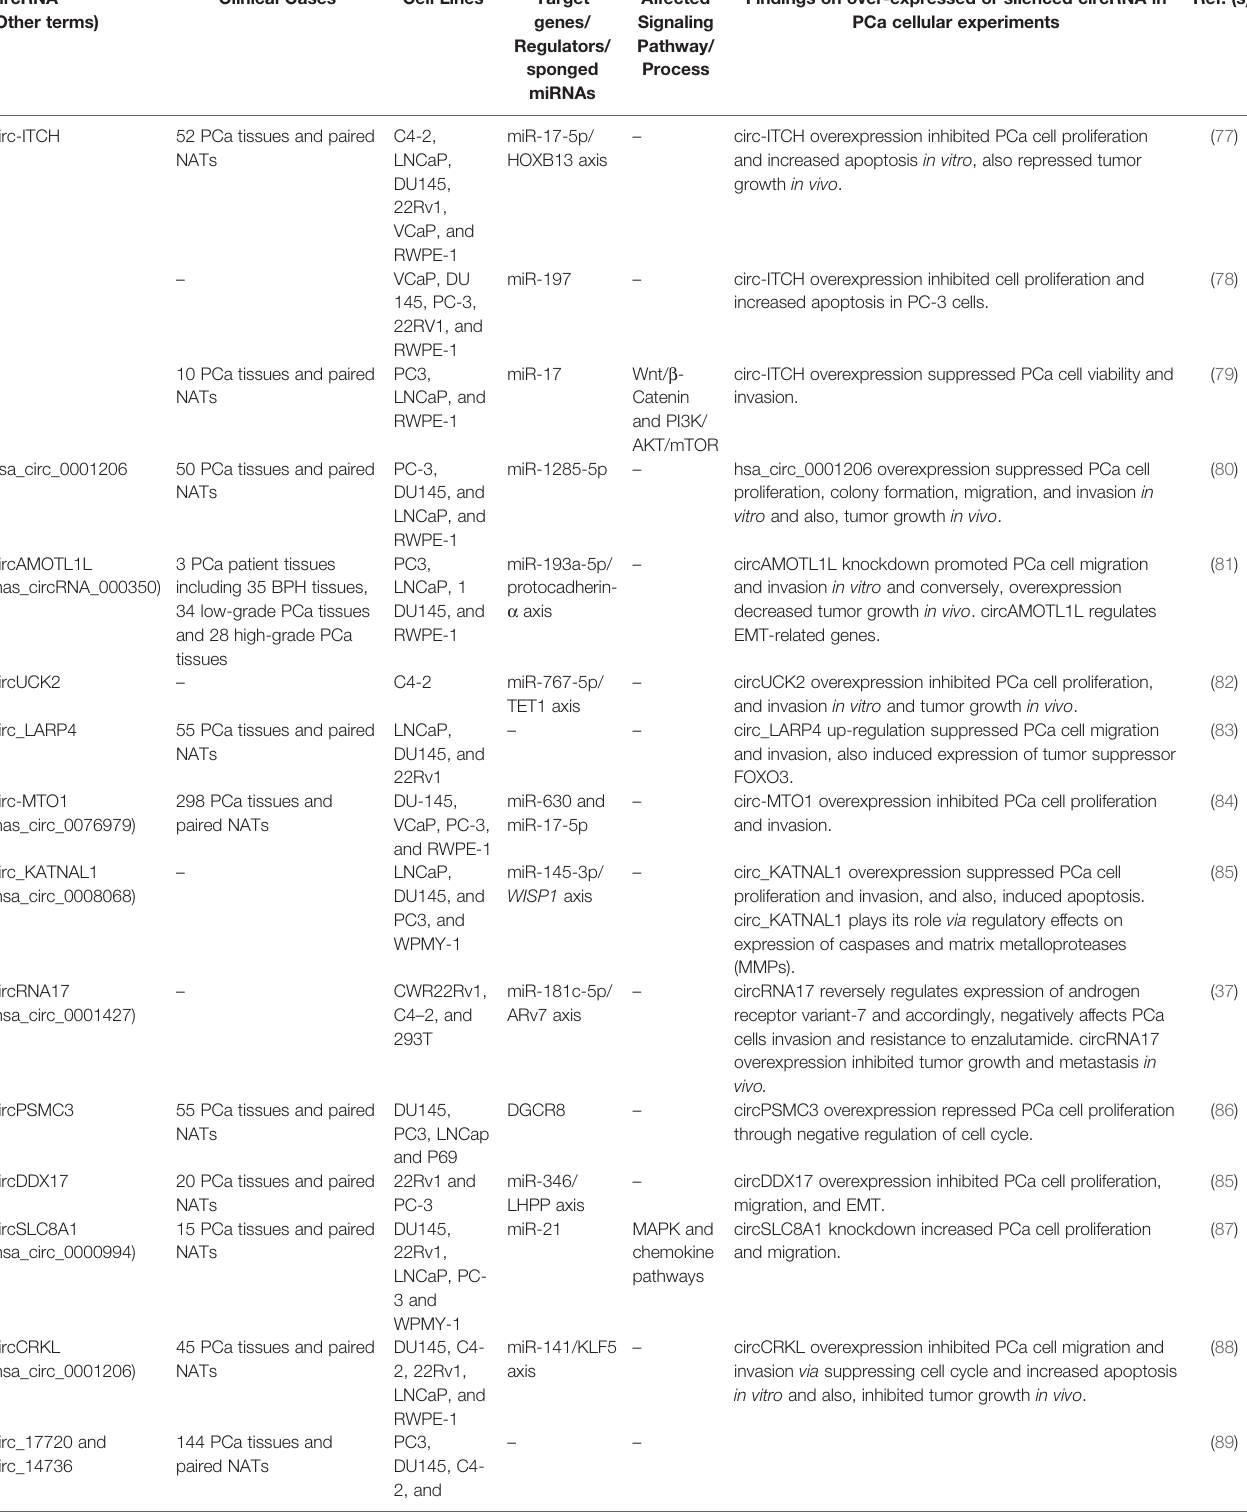
TABLE 2 | Down-regulated circRNAs in